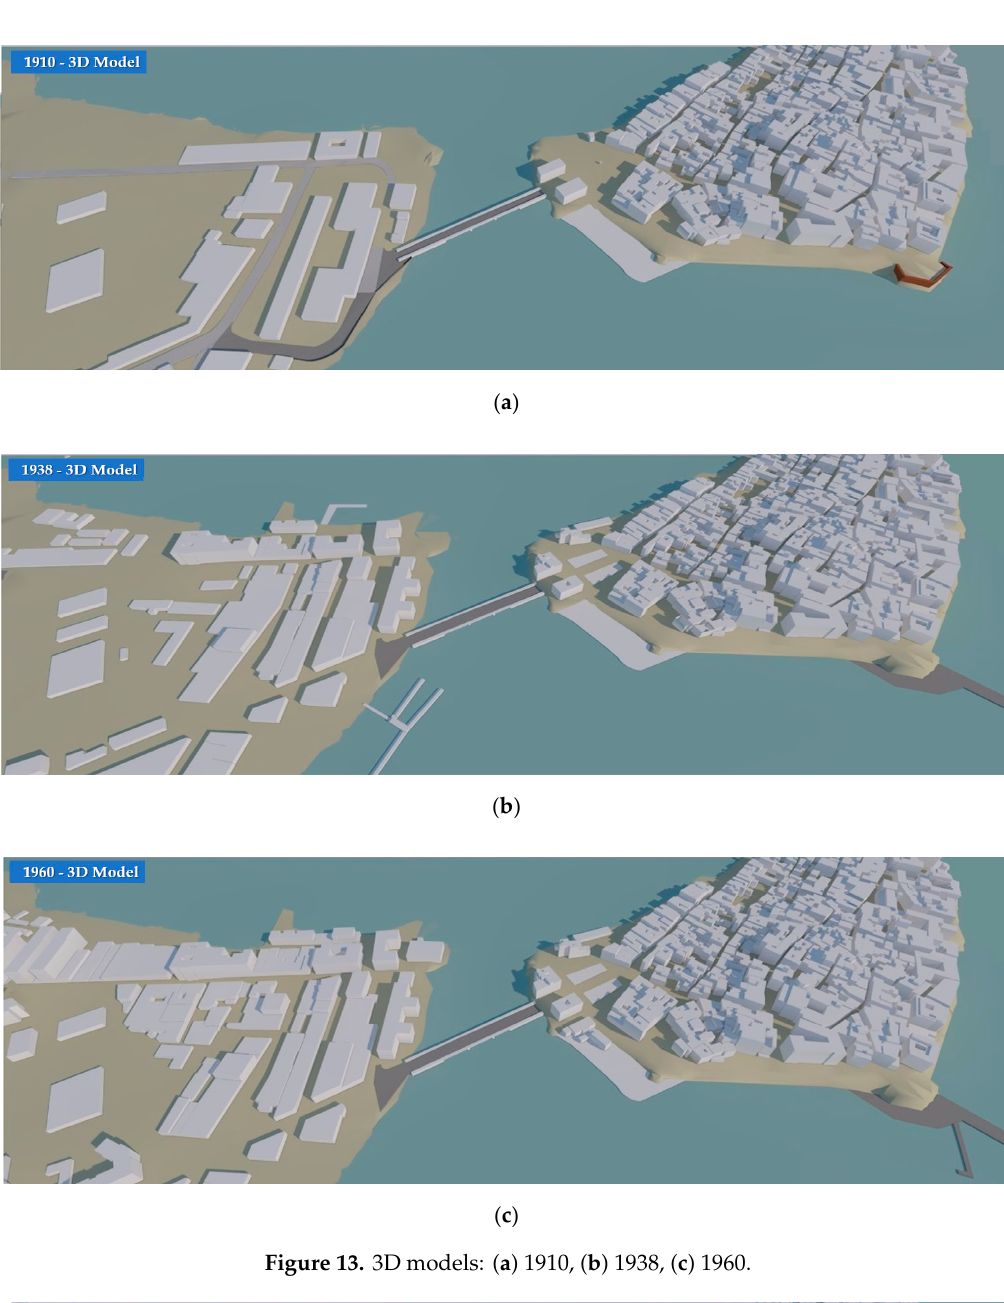
Figure 12 . 3D models: ( a ) 1810, ( b ) 1860, ( c ) 1885.